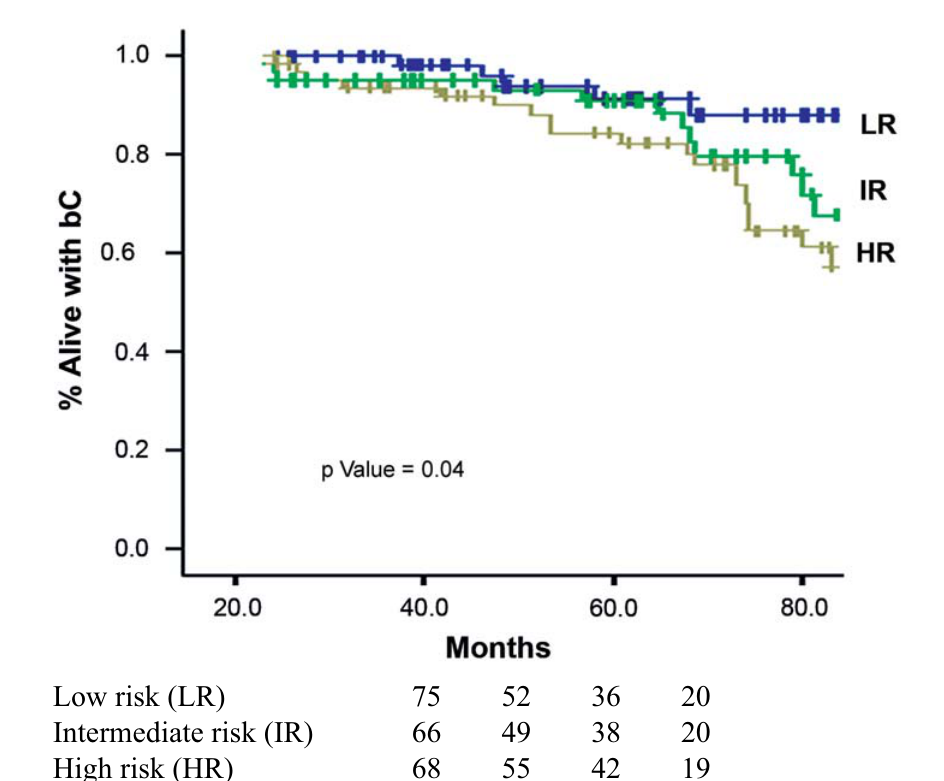
Figure 2 – Biochemical control according to the risk group for biochemical